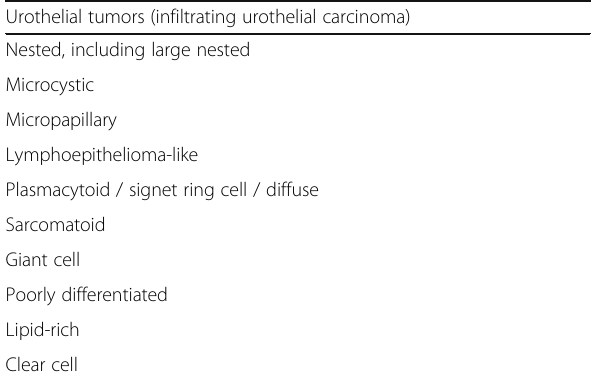
Table 1 2016 WHO Classification of tumor of the urothelial tract Urothelial tumors (infiltrating urothelial carcinoma) Nested, including large nested